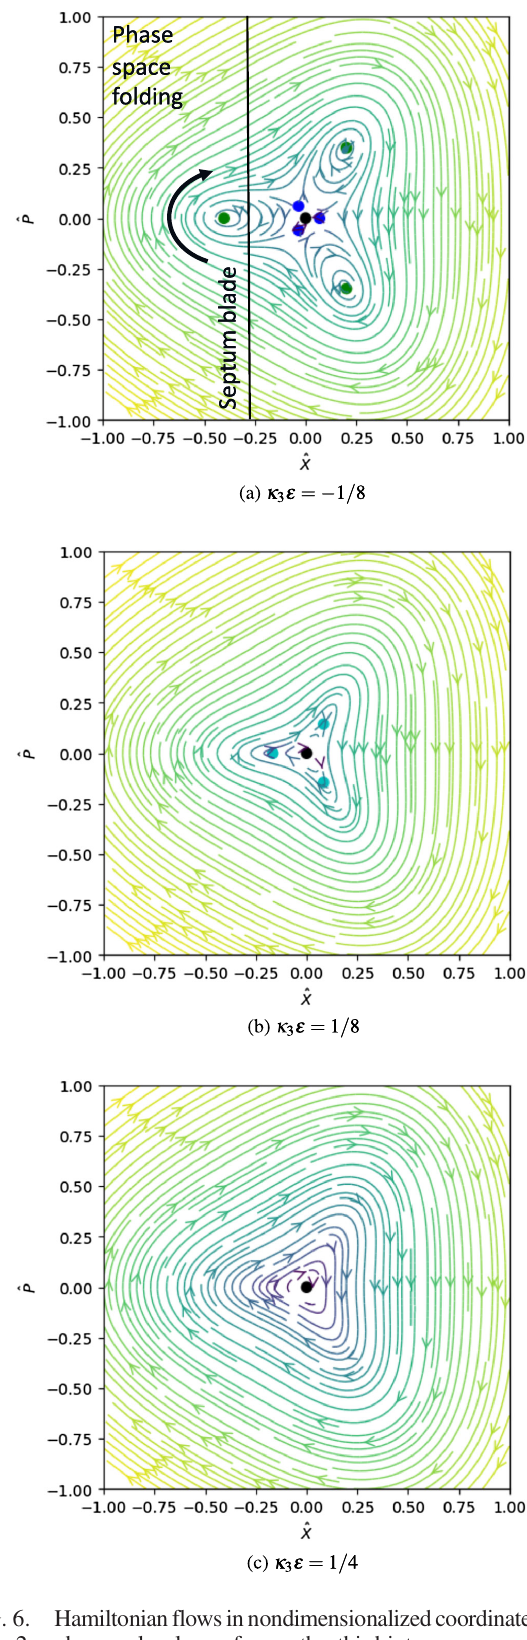
FIG. 6. Hamiltonianflows innondimensionalizedcoordinates,for κ ¼ 2 and several values of ε as the third-integer resonance is 3 crossed. Stable fixed points (green) and unstable fixed points